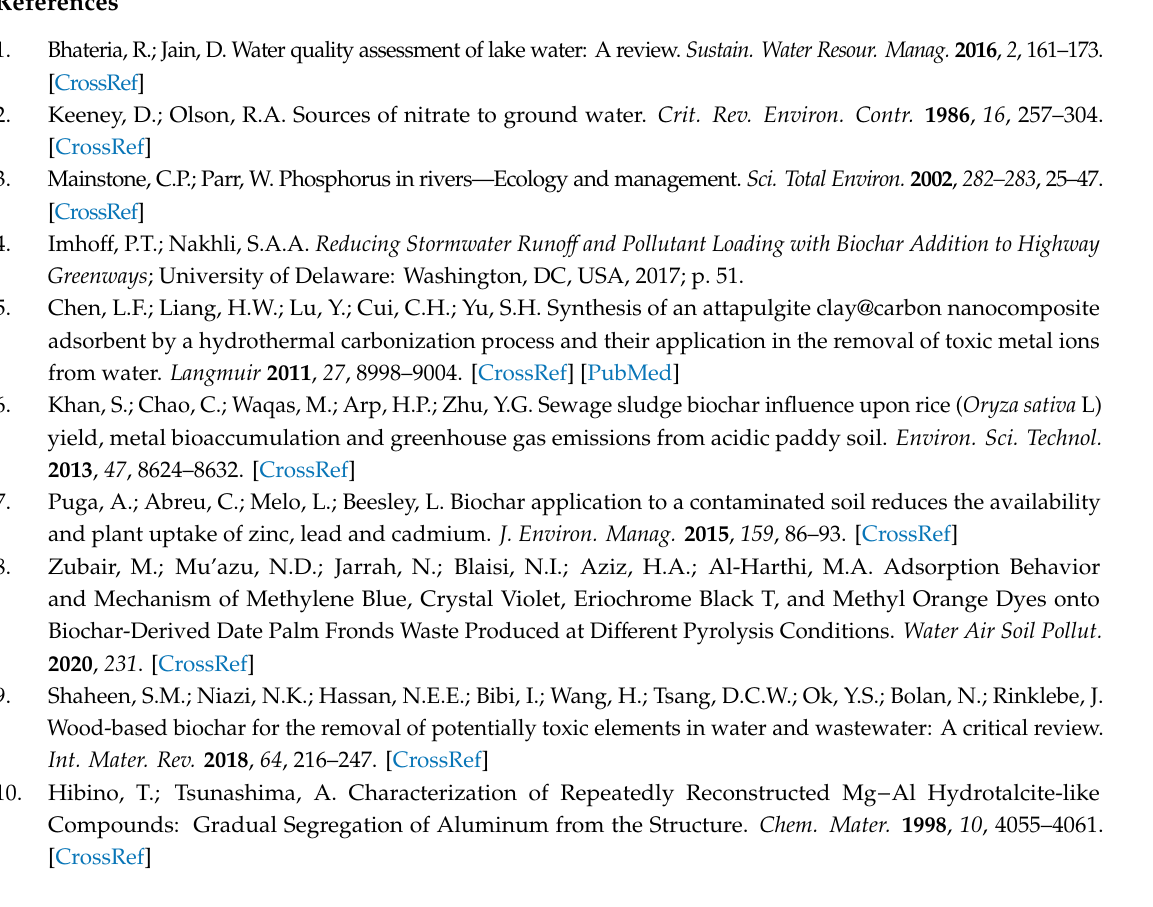
Figure S1: Electron images and elemental composition spectrums of composites by SEM-EDX technique: ( a ) SBAC 100 MgFe, ( b ) SBAC 500 MgFe, Figure S2: Equilibrium pH value of phosphate ( a ) and nitrate ( b ) after adsorption by SBAC-MgFe composites, Figure S3: Film di ff usion ( a,b ) and intraparticle di ff usion ( c,d ) model plots for adsorption of phosphate and nitrate on SBAC 100 MgFe composite, Figure S4: Plot of separation factor (R L ) versus initial concentration at three di ff erent temperature values for phosphate and nitrate adsorption on SBAC 100 MgFe, Table S1: Composition of wastewater obtained from domestic wastewater treatment plant of Imam Abdulrahman Bin Faisal